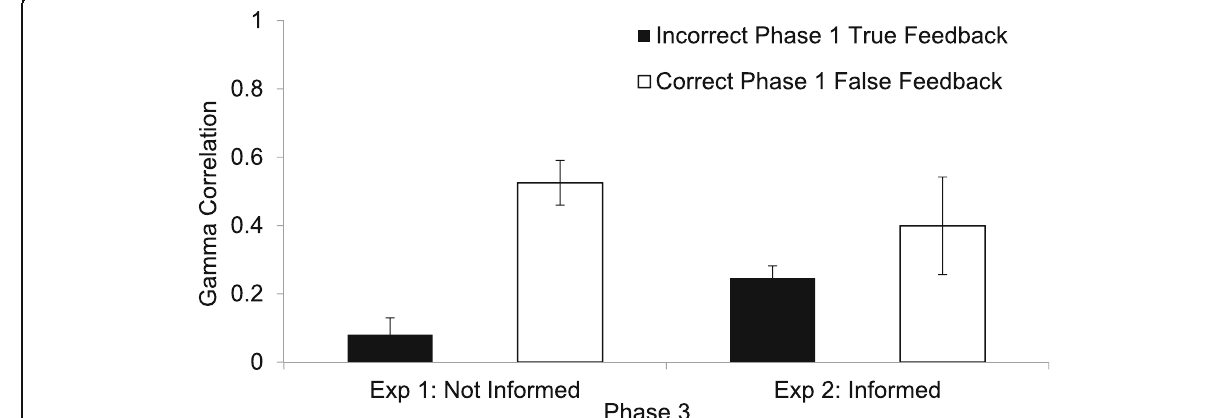
Fig. 2 The γ correlations between confidence in the factual accuracy of responses in the initial test and correct performance in Phase 3, in which participants were retested and were asked to provide the factually correct answer to each question. The solid black bar represents the standard hypercorrection condition in which an error had been committed in Phase 1 and true feedback was given. The white bar represents the condition in which the participant had originally been correct in Phase 1 and false feedback was given. On the left are results from Experiment 1, in which participants were not informed about whether the to-be-learned word, provided as feedback in red, was true or false. On the right are results from Experiment 2, in which participants were informed, immediately upon being presented with the to-be-learned word in red, whether the feedback was true or false. Error bars indicate the standard error of the